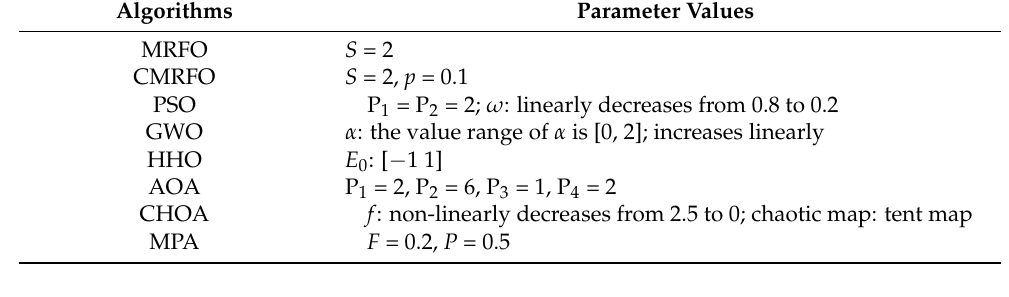
Figure 3. Exploration and exploitation phases in the CMRFO on the CEC2020 functions.